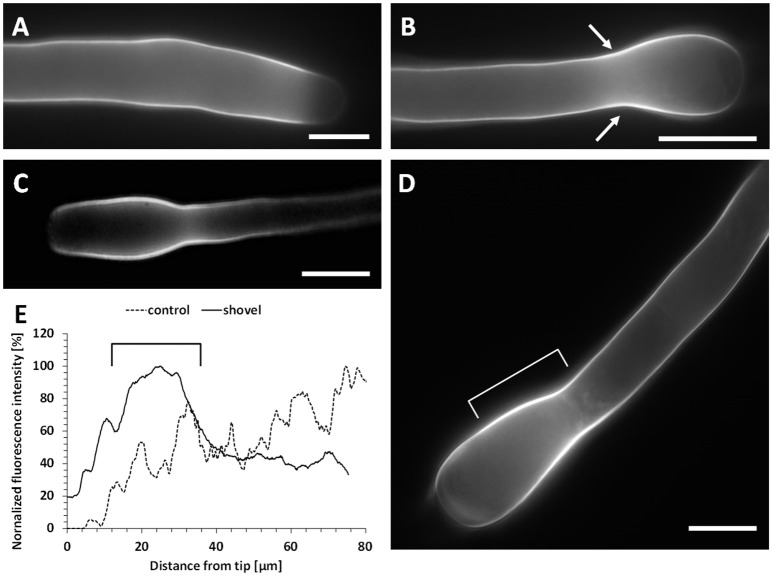
Distribution of callose in Spm-treated pear pollen tubes. (A) A control pollen tube showing absence of callose in the tip. (B) In balloon-shaped pollen tubes, callose accumulates in the neck region (arrows). (C) In snake-shaped pollen tubes, callose still accumulates in the neck region and it is still absent from the tip. (D) In shovel-shaped pollen tubes, callose showed a consistent accumulation around 20–30 μm, as also shown by the relative fluorescence intensity (E). The square bracket in (D) corresponds to the region indicated by the square bracket in the graph of (E). Bars: 10 μm. Data are representative of three independent experiments.